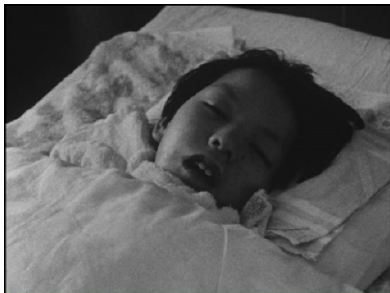
Figure 3. The medium shot of Kumiko asleep in bed. Still from Minamata: The Victims and Their World (1971), director Tsuchimoto Noriaki.